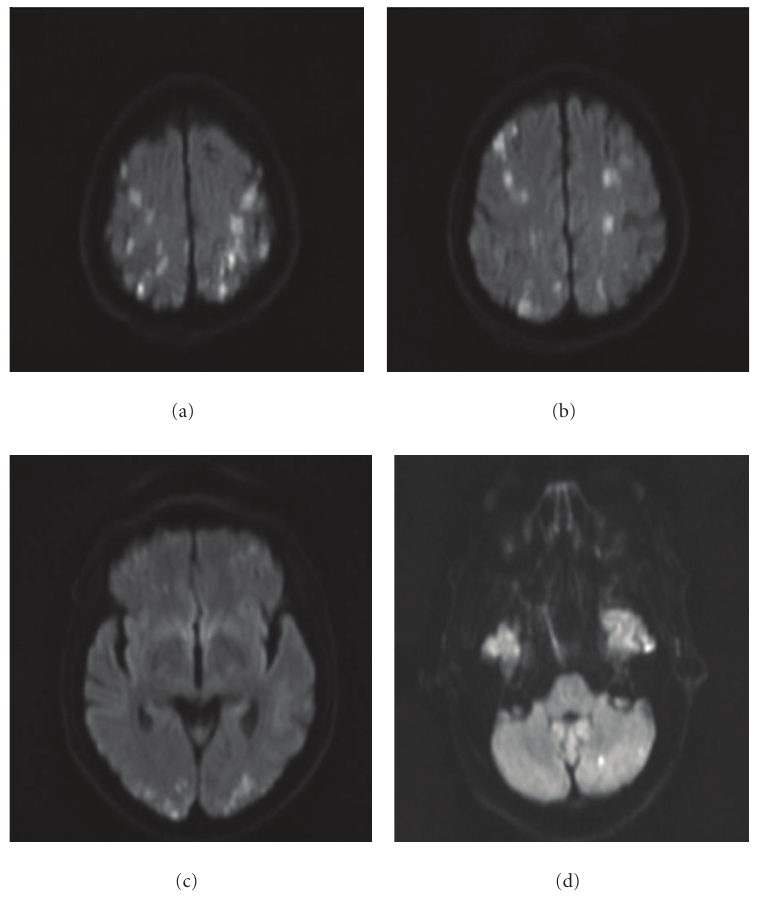
Figure 1: Di ff usion-weighted imaging shows multiple zones of di ff usion restriction in the watershed regions of both cerebral hemispheres and in the left cerebellar